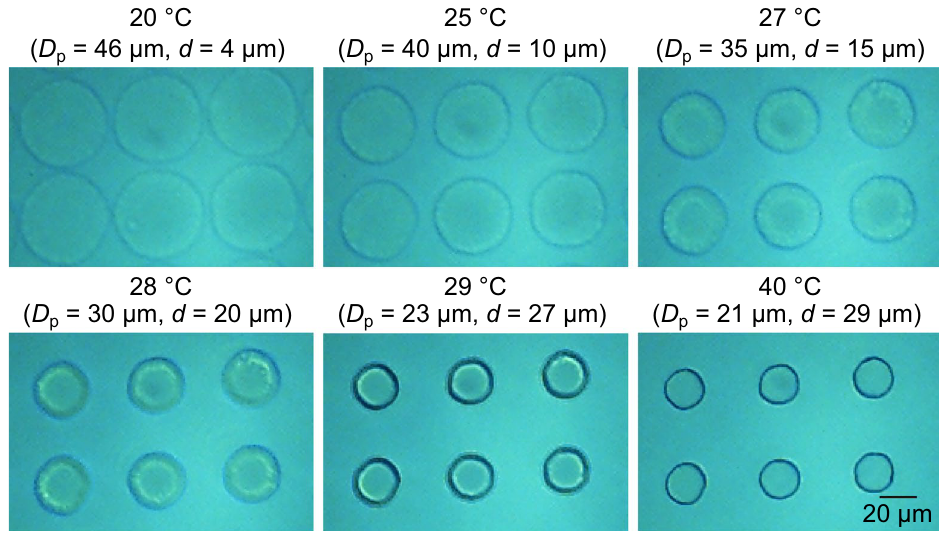
Figure 4. Top-view photomicrographs of the PNIPAM micropillars confined in the PDMS microchannel filled with the aqueous solution at different temperatures.